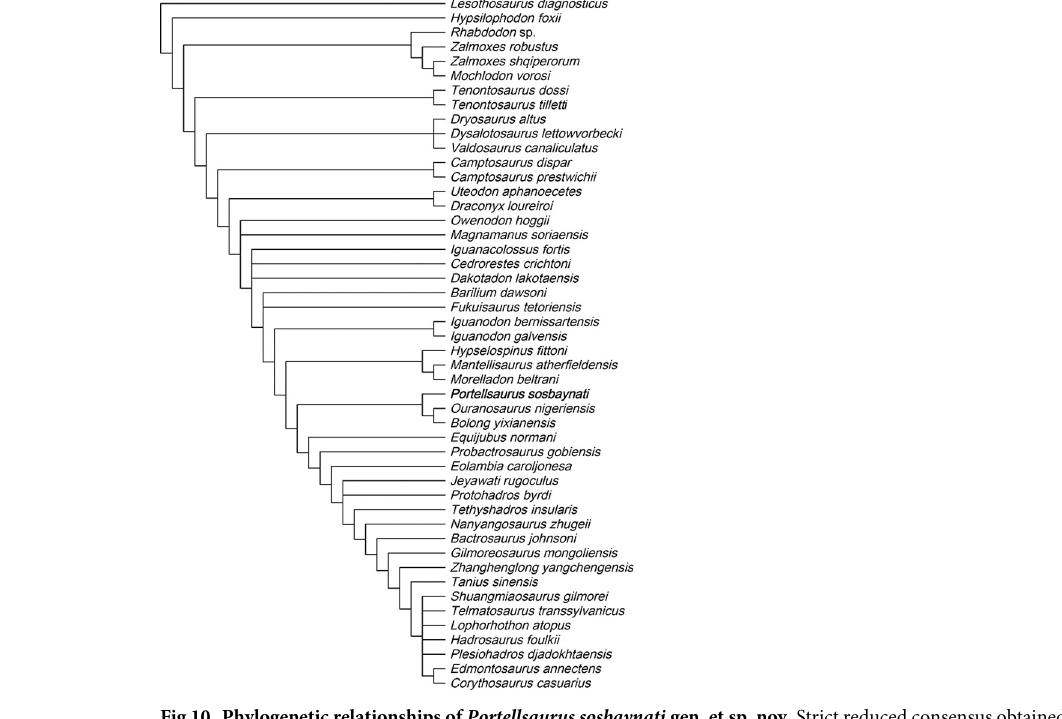
Fig 10. Phylogenetic relationships of Portellsaurus sosbaynati gen. et sp. nov. Strict reduced consensus obtained after running the IterPCR script in the MPTs from ordered dataset.